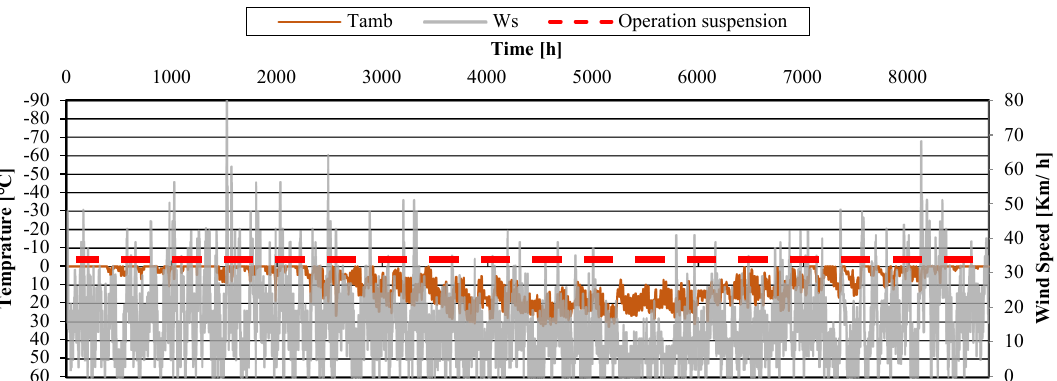
Figure 4. Outdoor ambient air temperature and wind speed condition.